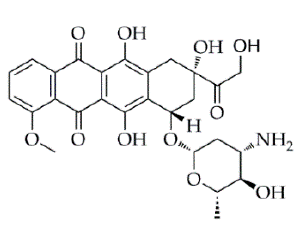
Figure 1. Structure of epirubicin.